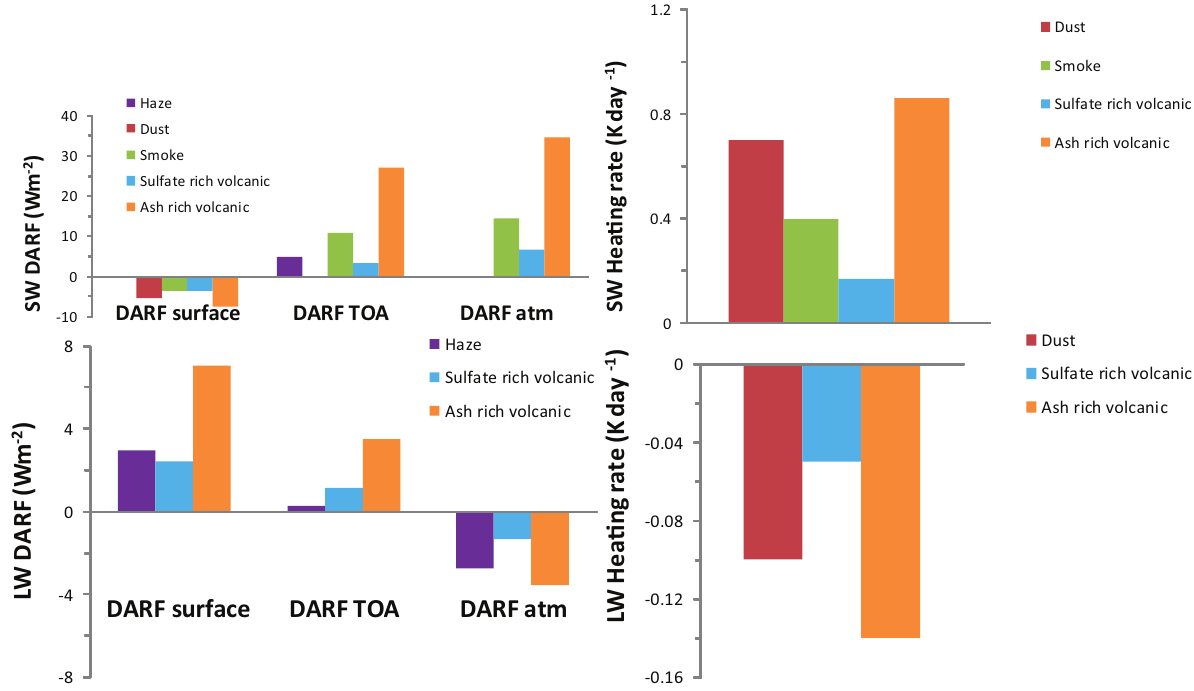
Fig. 15. (a) SW direct radiative forcings (DARFS) and (b) SW heating rates for haze (Quinn et al., 2007), dust (Stone et al., 2007), smoke (Stone et al., 2008), and ash rich and sulfate rich volcanic aerosols (this study). Values of forcing for dust were only available at the surface. (c) LW DARFs for haze (Ritter et al., 2005) and ash rich and sulfate rich volcanic aerosols (this study). (d) LW cooling rates for dust (Stone et al., 2007) and ash rich and sulfate rich volcanic aerosols (this